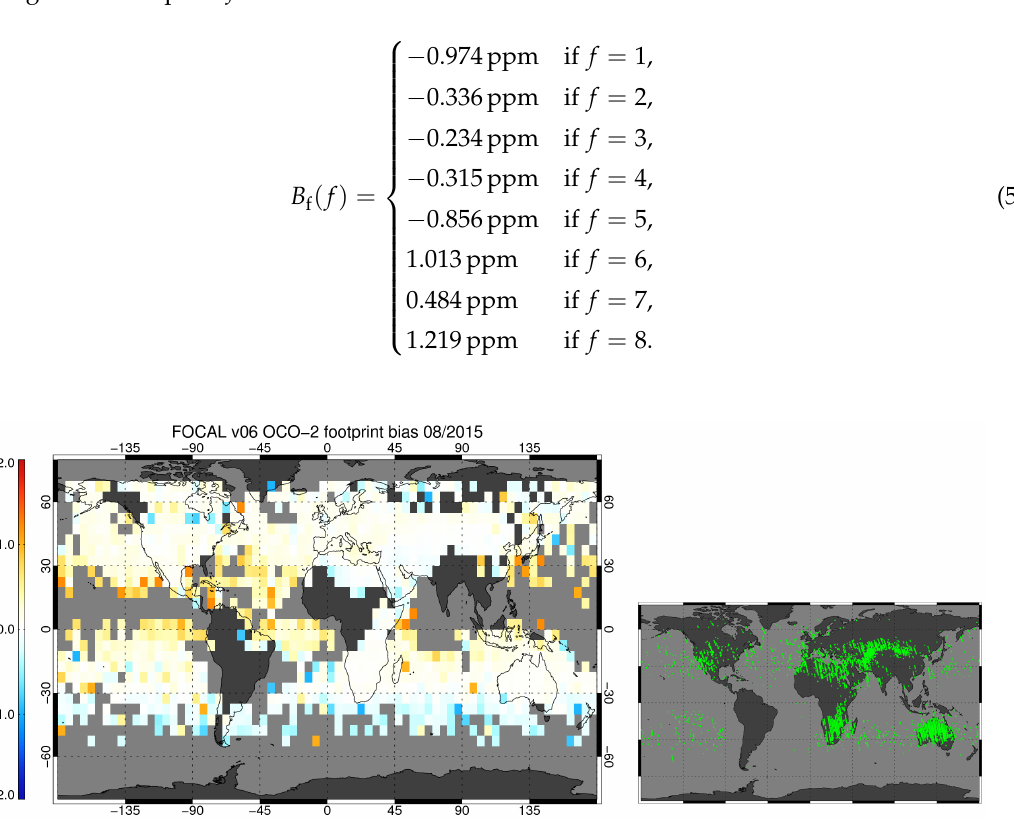
Figure 9. FOCALv06 OCO-2 footprint bias pattern (Equation (5)) at the example of August 2015 ( left ) and sampling of soundings used to determine the footprint bias ( right